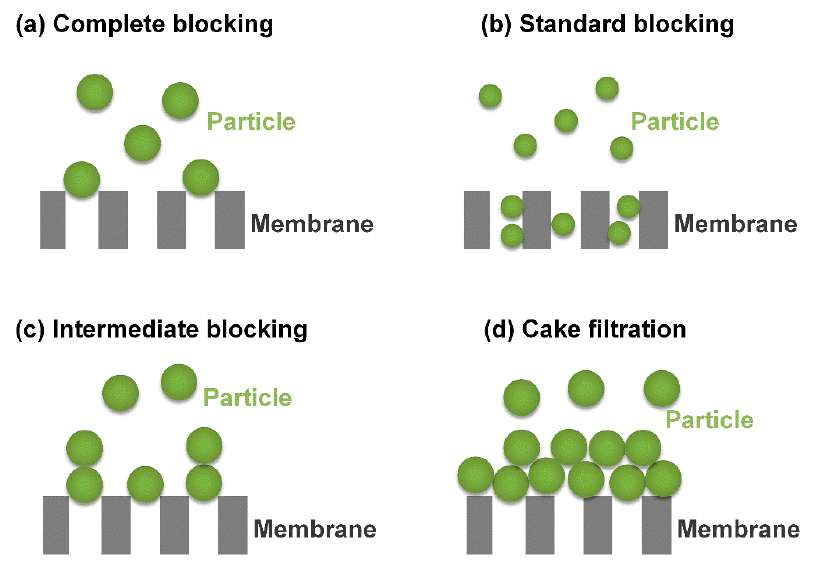
Figure 3. Schematic view of pore blocking during membrane